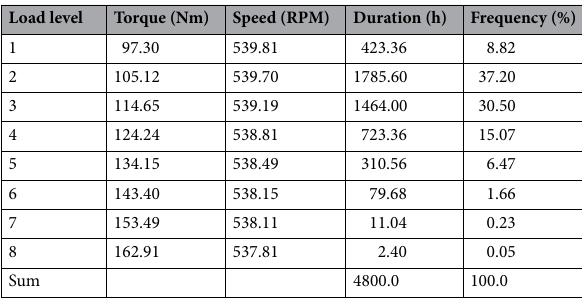
Table 1. LDD for gear rating of maize harvester gearbox 15